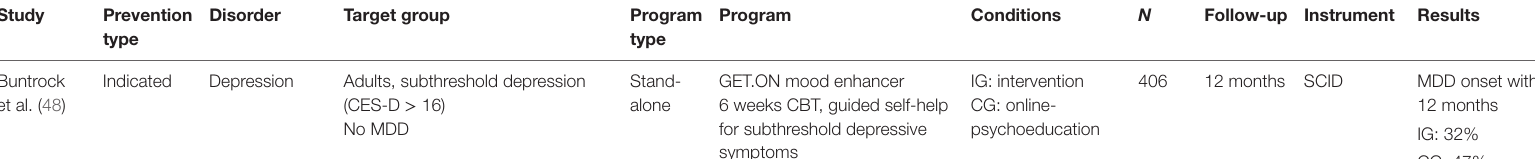
TABle 1 | Summary of included randomized controlled trials that assessed MHD onset using categorical ICD/DSM diagnostic